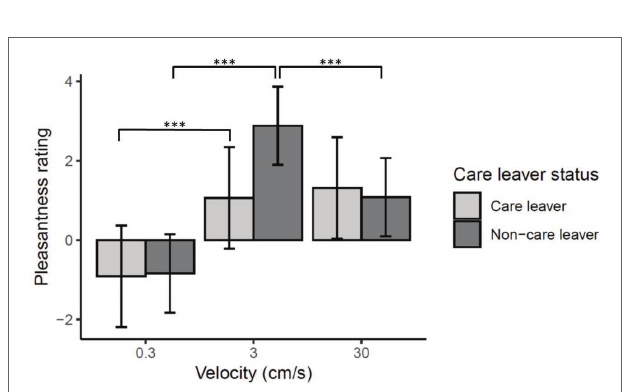
FIGURE 2 | Median Touch Experiences and Attitudes Questionnaire (TEAQ) subscale scores for care leavers and non-care leavers with error bars showing 25th and 75th percentiles. Care leavers reported significantly lower levels of positive childhood touch than non-care leavers (*** p < 0.001). No other differences were significant. FFT, friends and family touch; CIT, current intimate touch; ChT, childhood touch; ASC, attitude to self-care; AIT, attitude to intimate touch; AUT, attitude to unfamiliar touch.